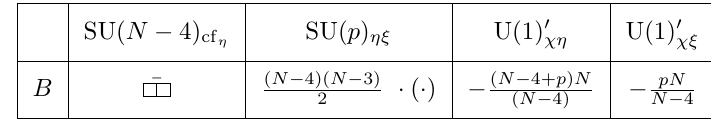
Table 13 . IR fied in the GG model in the dynamical Higgs